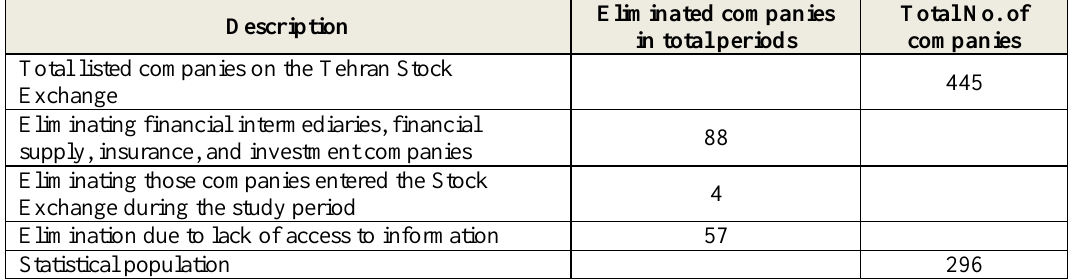
Table 1 . No. of companies of the statistical population by imposing the conditions of sample selection Description